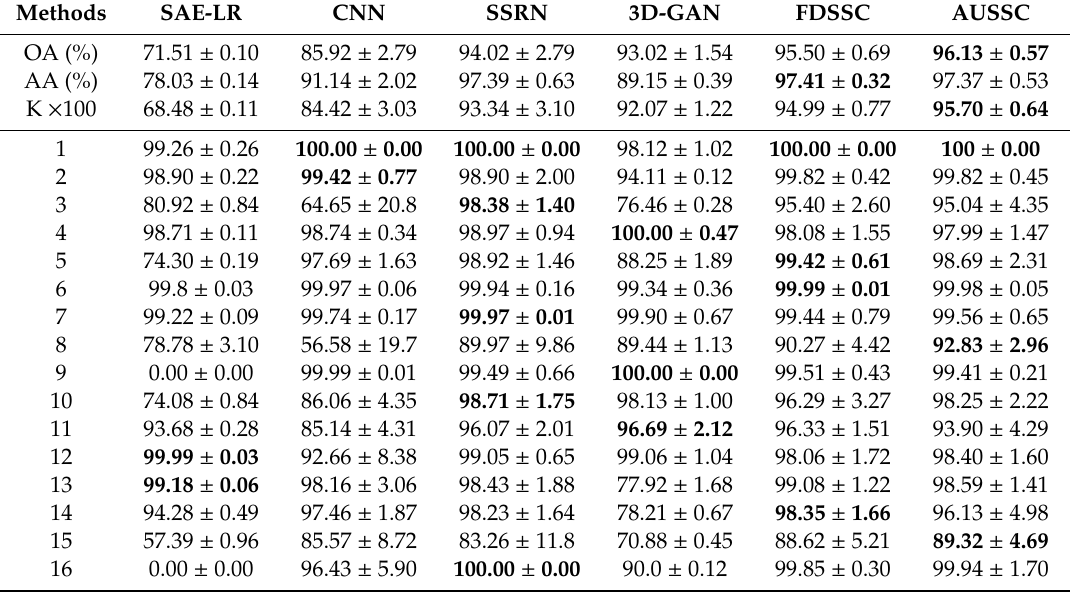
Table 6. OA, AA, K, and accuracy for each HSI category in the Salinas Scene (SS) data set.